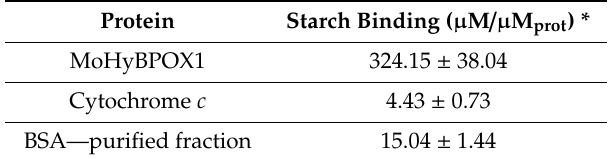
Table 5. Result of soluble starch binding on purified and desalted MoHyBPOX1 and other proteins. Presented values are means ± standard